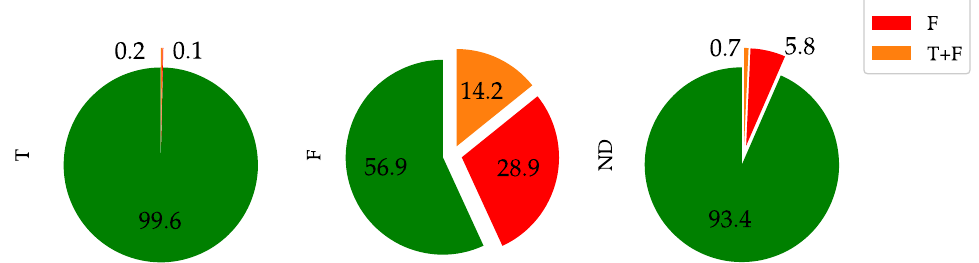
Figure 13. Validity assessment comparison: 2nd Harmonic labels with respect to DELFI outcomes for the CN Subset.